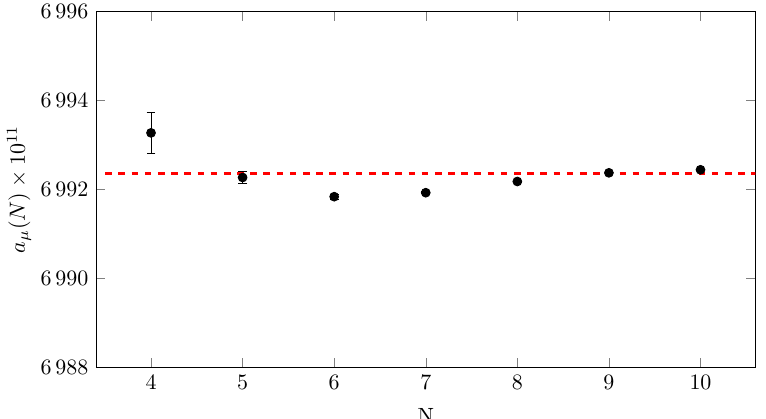
(N) results with estimated systematic error bars. The horizontal red dashed line is Figure 6 . a HVP µ the a HVP value of the µ